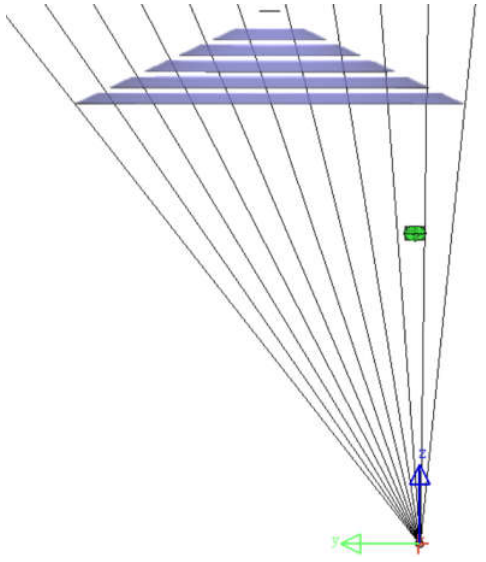
Figure 3. Ray tracing considers the electron beam evaporation source as a similar point light source with a divergence angle of 60